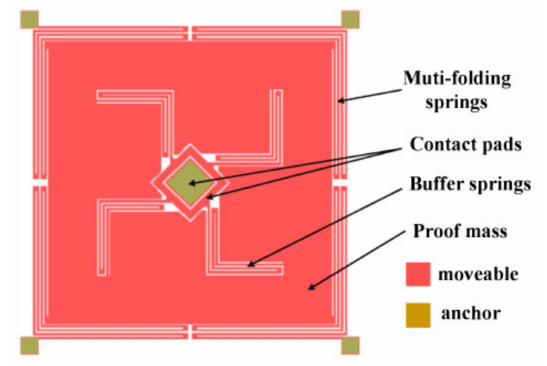
Figure 3. Schematic of the two-axis low-g inertial